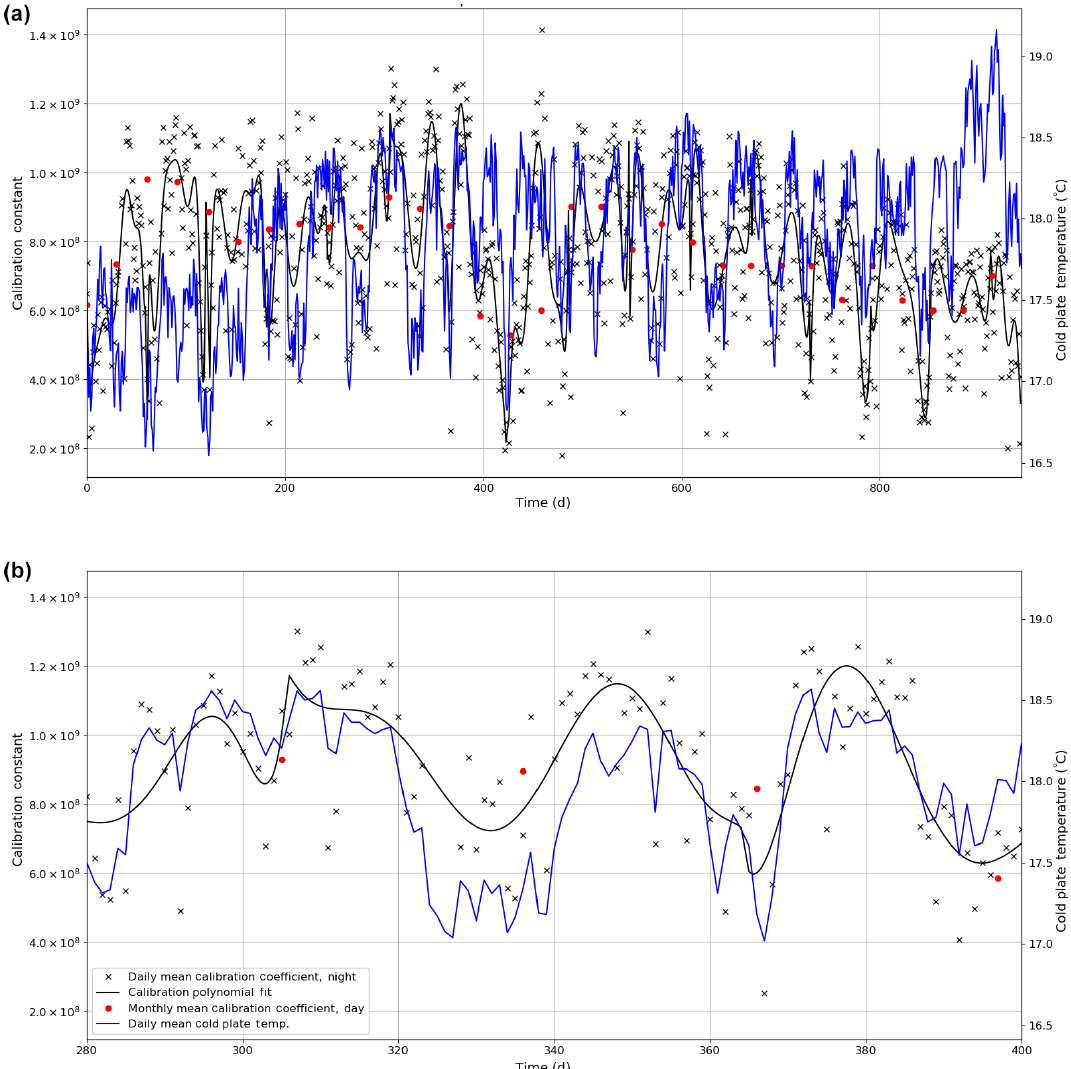
Figure 3. The average CATS nighttime calibration coefficient for each day (black x), polynomial fit of the average calibration coefficient with time (black line), the CATS monthly daytime calibration coefficient (red circle), and the daily average cold plate temperature (blue line) for the entire mode 7.2 data record (April 2015 through October 2017) in (a) . Zooming into a smaller time period (January 2016 through April 2016, b ) demonstrates the correlation between calibration values and the instrument cold plate temperature. The correlation coefficient between the daily average nighttime calibration coefficient and cold plate temperature for the January–April 2016 period is